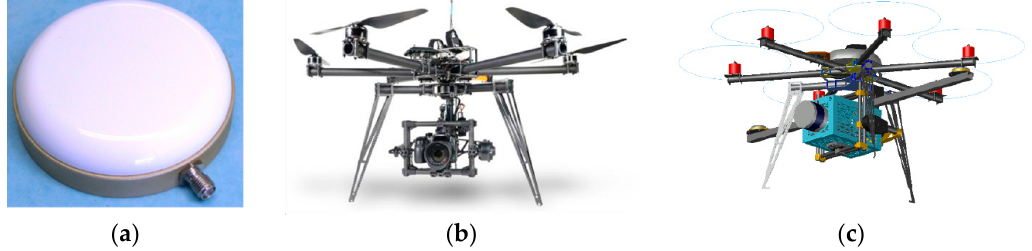
Figure 2. ( a ) GNSS Antenna (G5Ant-2AMNS1); ( b ) Hexacopter CineStar 6HL; ( c ) Sensor box